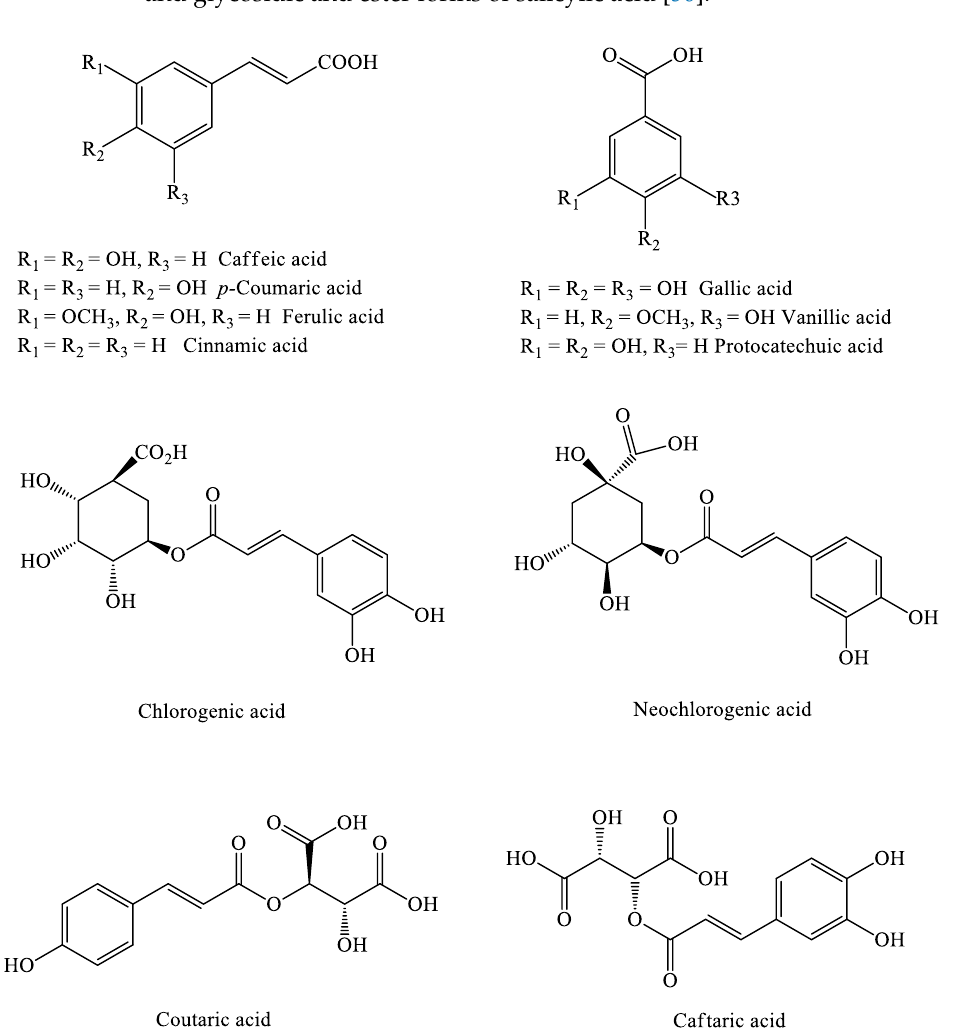
Figure 2. Chemical structures of phenolic acids contained in berries.